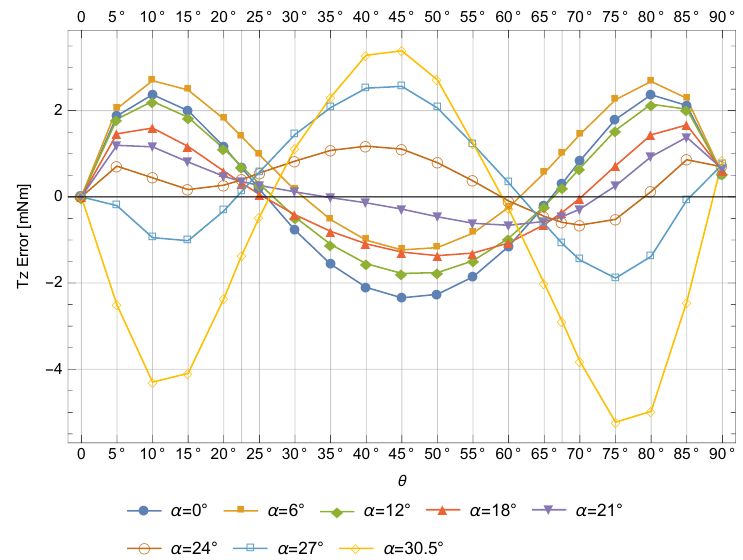
Figure 11. Error of the approximated torque function for T z ( α , θ ) in comparison to simulations.